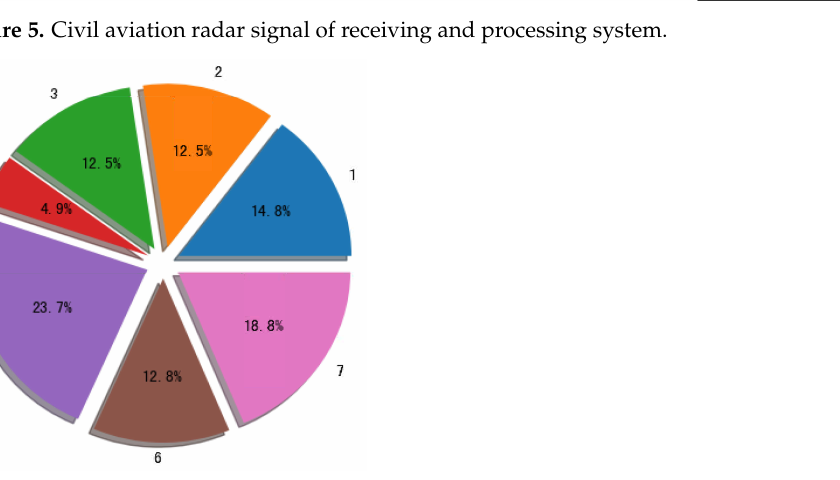
Figure 6. Samples’ distribution of different emitters. Equilibrium and disequilibrium sample collected from 7